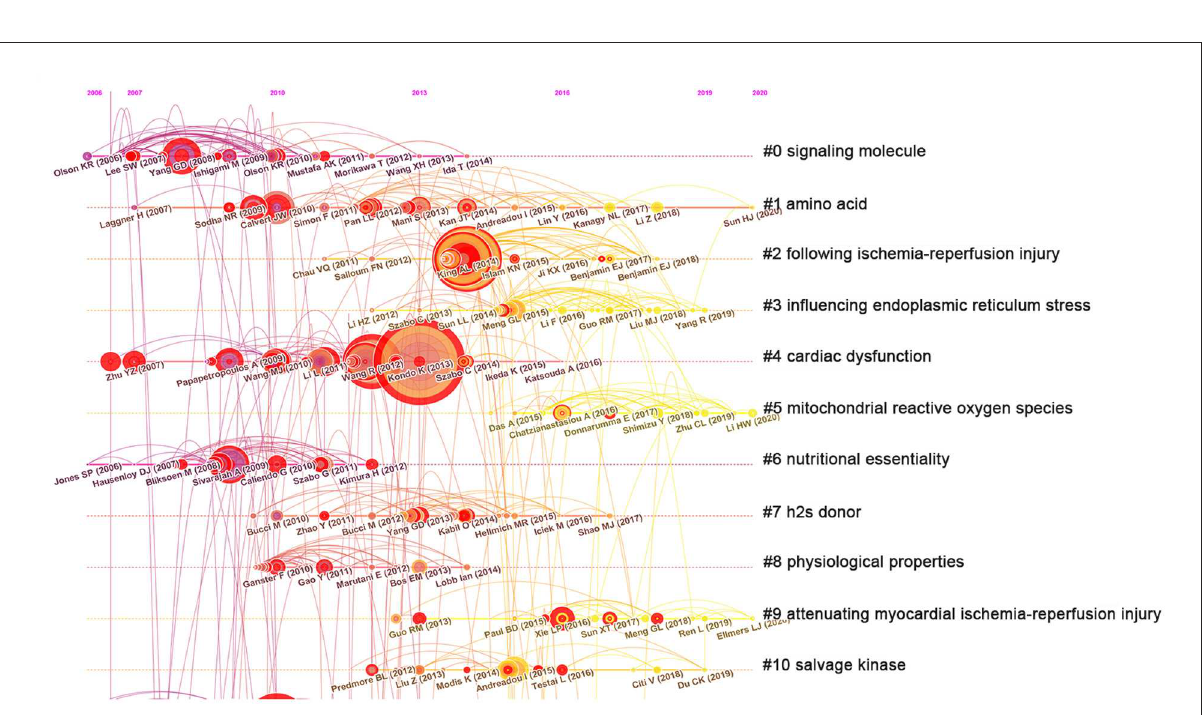
FIGURE5 Timeline view of co-cited references related to hydrogen sulfide in heart preservation